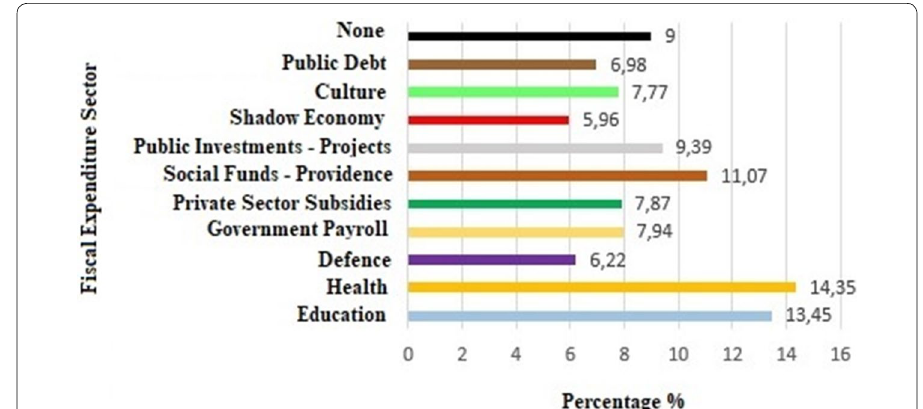
Fig. 9 The structure of the expenditure mix of a desired fiscal